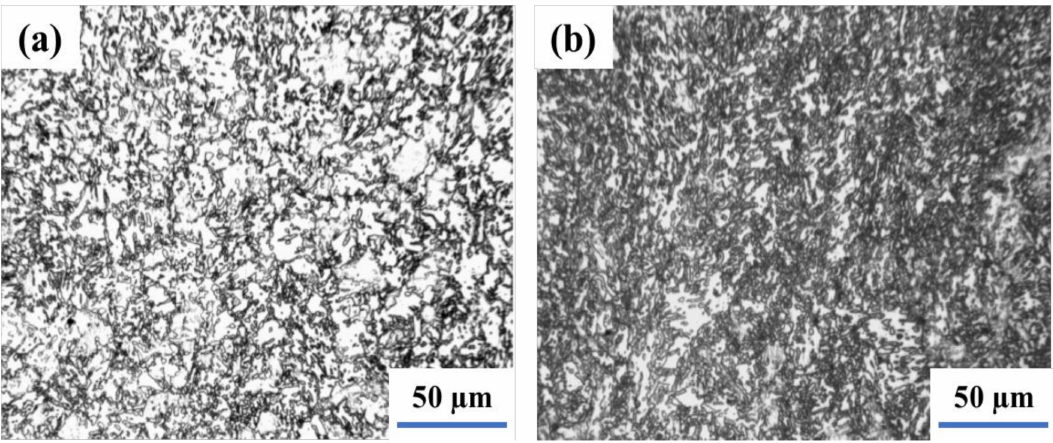
Figure 4. The Microstructure of weld joint after intercritical normalizing at 740 ◦ C − weld ( a ) and HAZ ( b ).